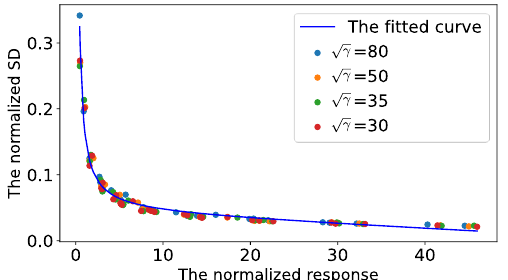
Figure 3. An illustration of the normalized SDs vs. the change in SNRs ( γ ). The blue, orange, green and red points denote the sampling from the SNRs 80 2 , 50 2 , 35 2 and 30 2 , respectively. The blue curve is fitted by all sampling. It can be seen that the fitted curve successfully describes the relationship between the normalized SDs and the normalized responses at different SNRs.